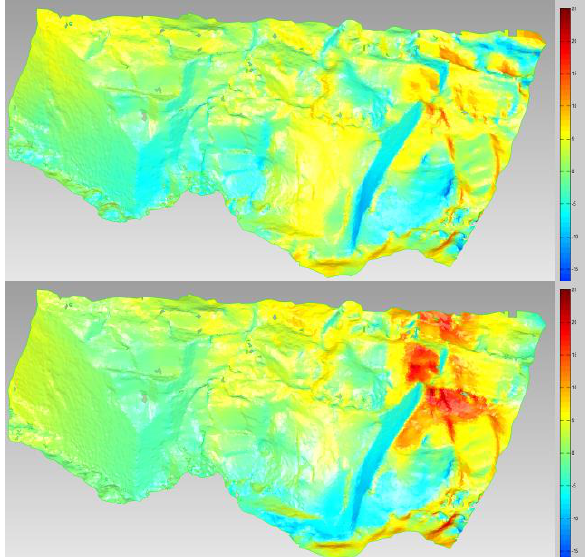
Figure 9. MC simulation comparison: SCS calibration solution (top); MCS calibration solution